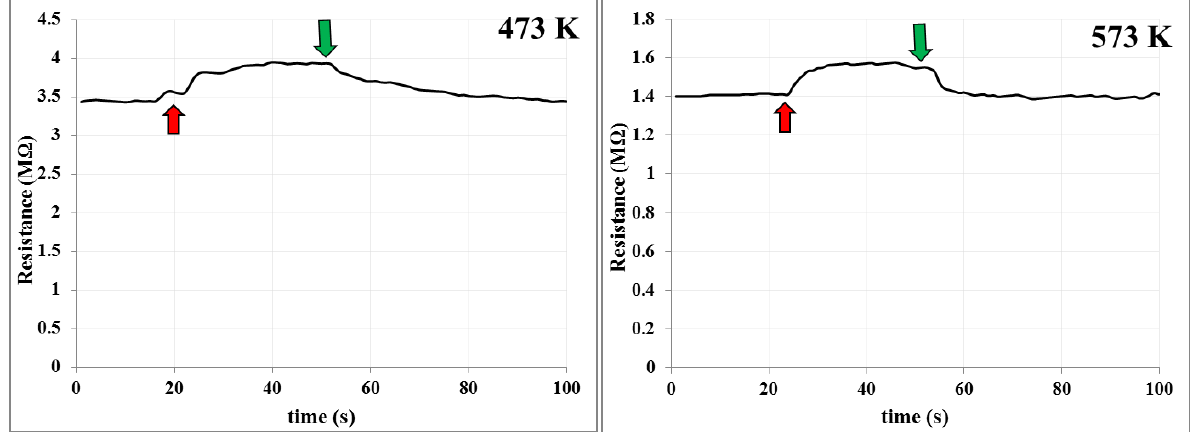
Fig.10: Variation of with time for (SnO) 473 and 573 K.